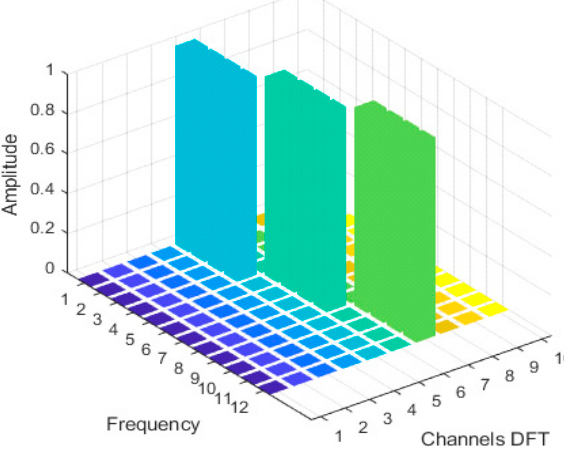
Figure 2. Frequency response of channels of the bandpass filters.